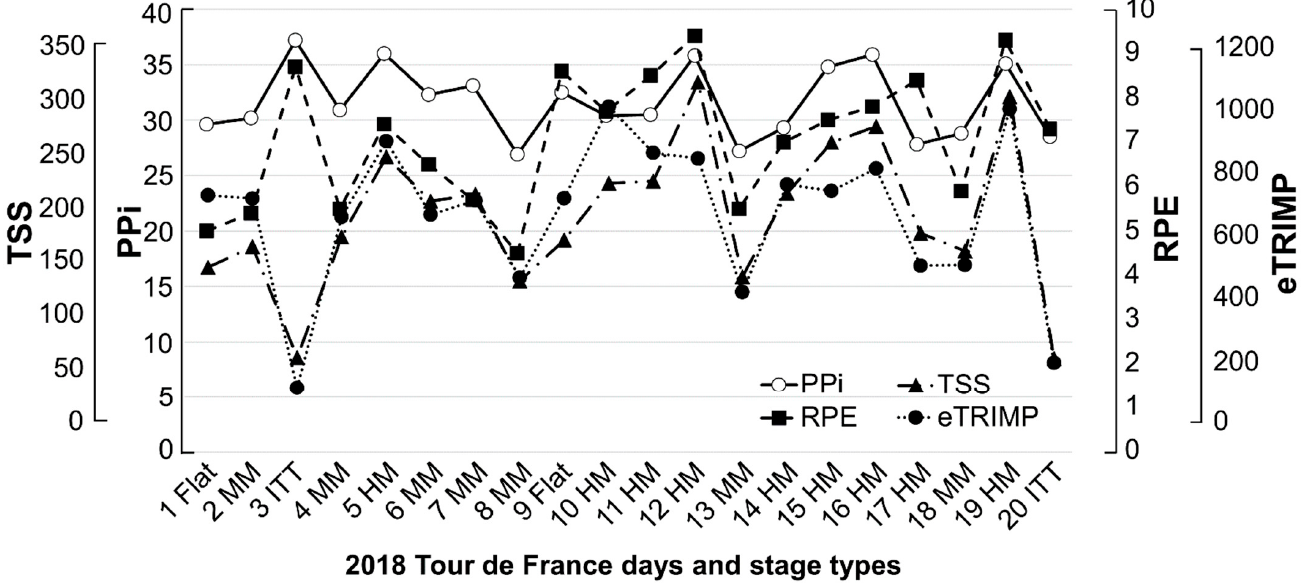
Figure 2. Comparison of the Power Profile Index against current intensity quantification methods.